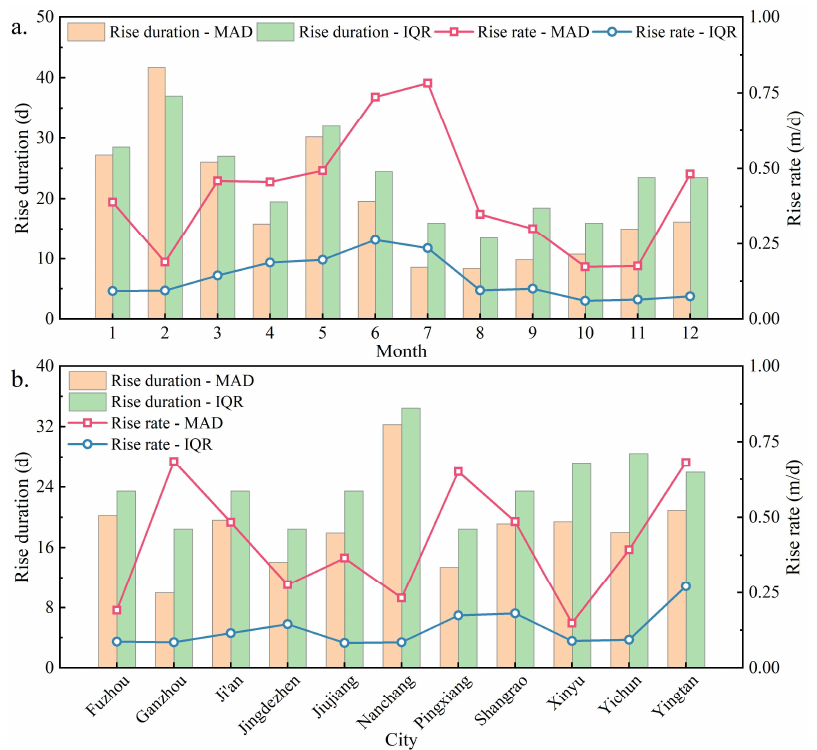
Figure 8. Statistical chart of abnormal rising threshold of groundwater level by month ( a ) and by city ( b